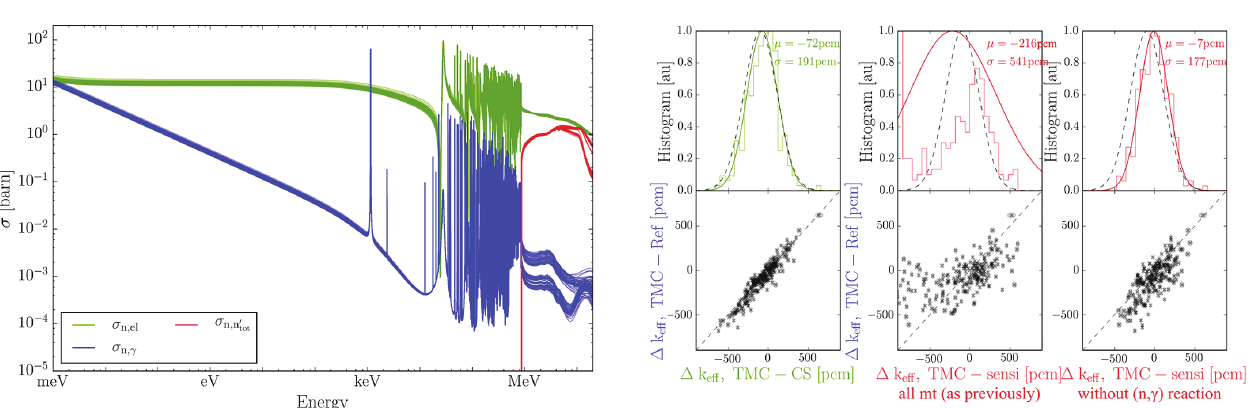
Fig. 6. 80 56 Fe random cross section, using 2 random nuclear models times 40 random parameters.